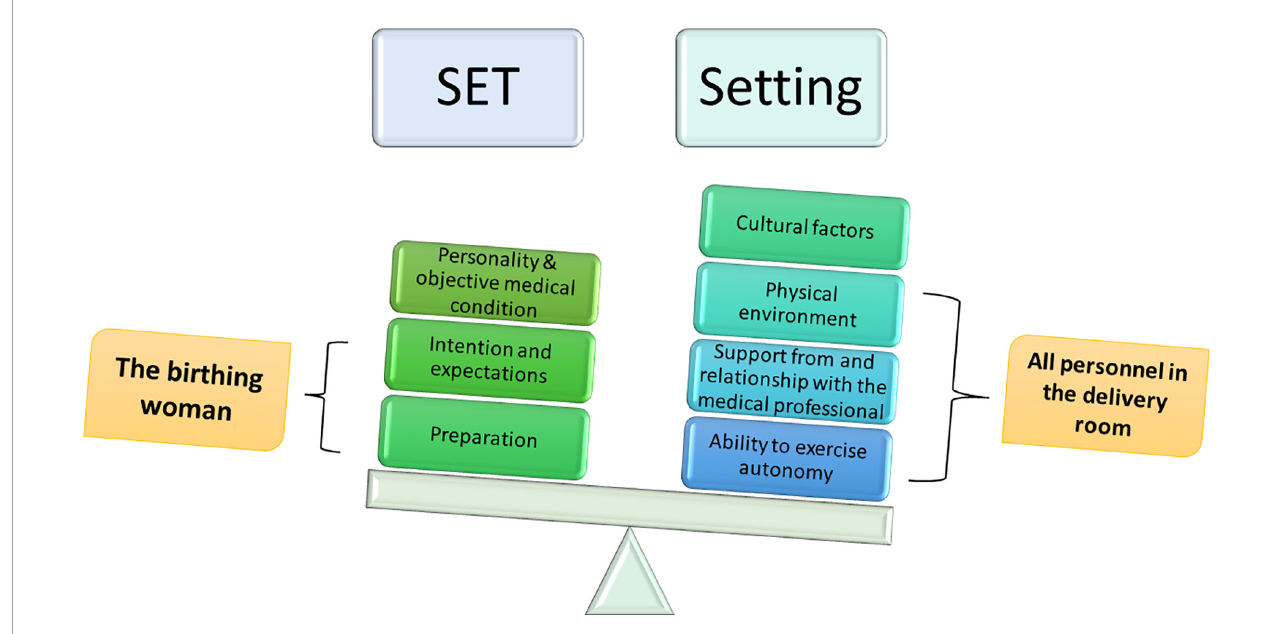
FIGURE4 How can the science of consciousness promote the science of birth?